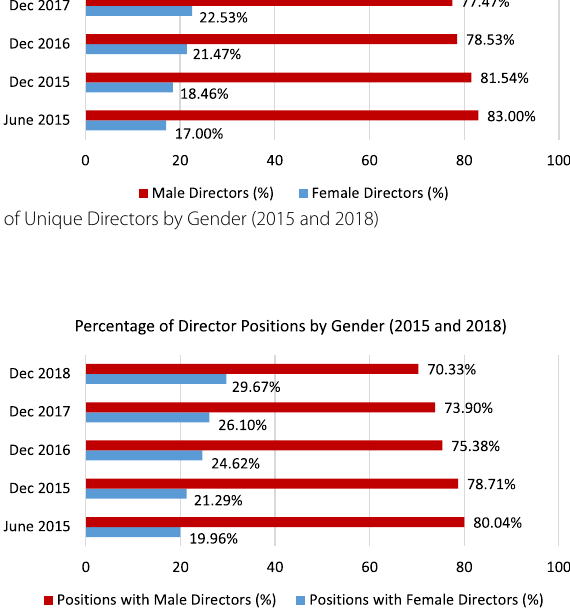
Fig. 2 Percentage of Director Positions by Gender (2015 and